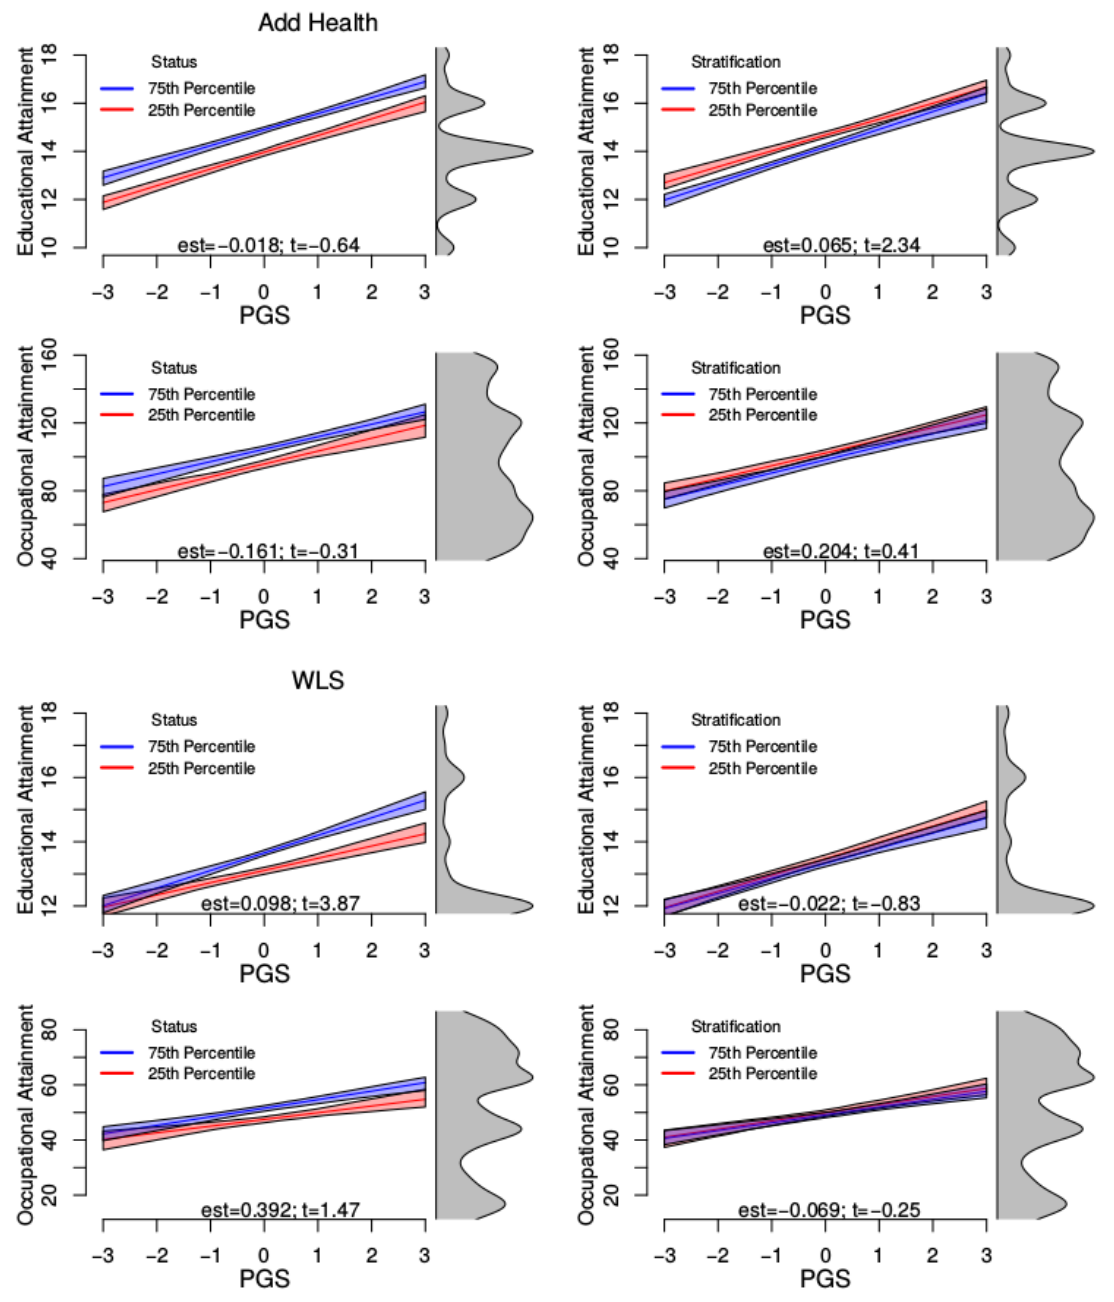
Figure 5: Prototypical plots for direct tests of GxE with candidate environments. Environments are at the 25th and 75th percentiles of the school-level distribution. Results are for females of mean age (in the WLS, they are also assumed to be graduate respondents). The right-hand side of each panel shows the distribution of the variable on the y axis. est, estimate; PGS, polygenic score; WLS, Wisconsin Longitudinal Study.